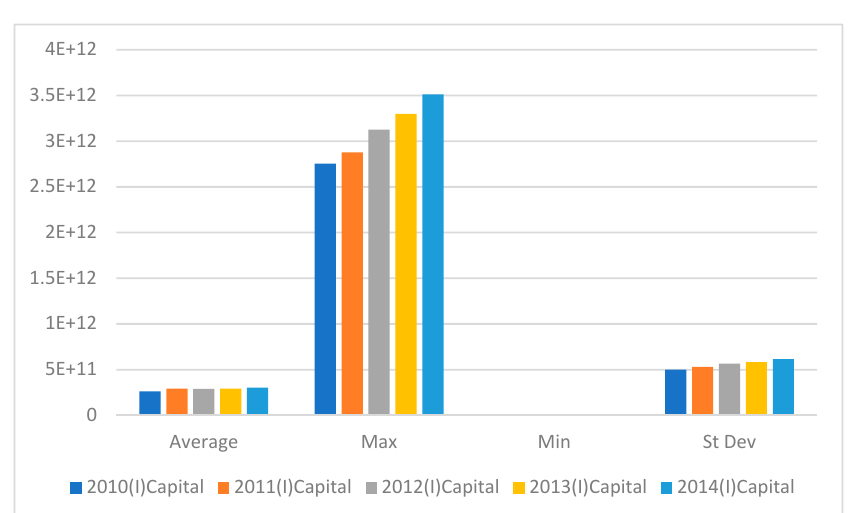
Figure 1. Labor Input variables from 2010–2014.